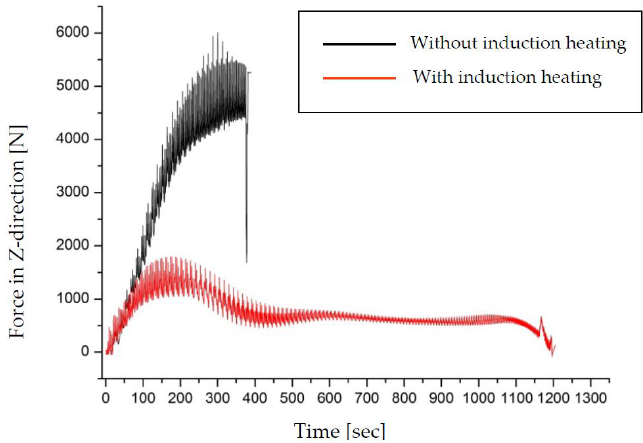
Figure 6. Force in the z-direction during forming both with and without induction heating at a power of 12.5 kW for 62° cone wall angle test samples formed at a 1.5 m/min feed rate. The forces in the z-direction without induction heating (room temperature) exceed 5500